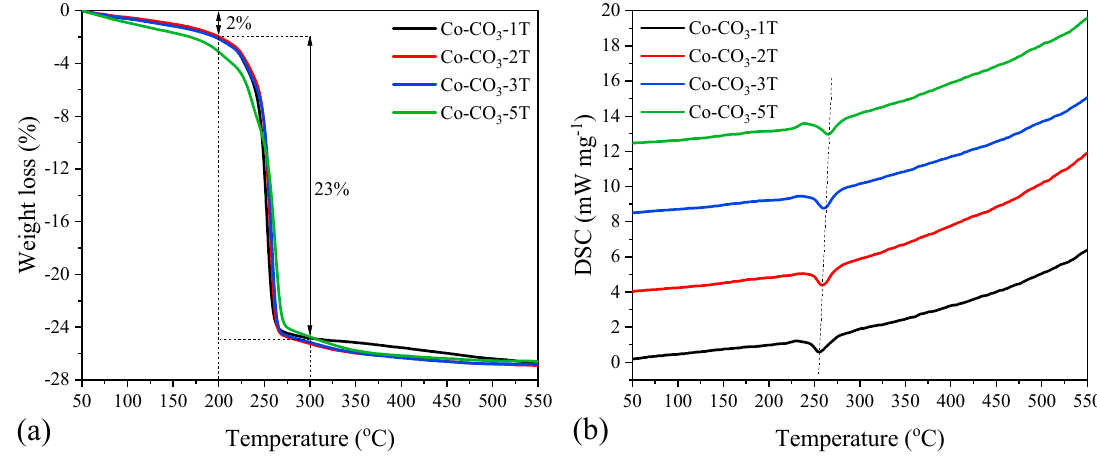
Figure 1. ( a ) TG and ( b ) DSC curves of the catalyst precursors.